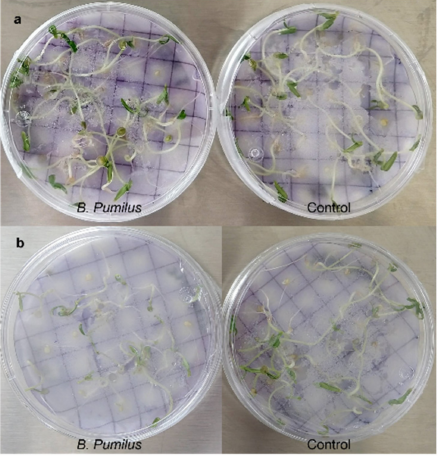
Figure 4. Effect of Bacillus pumilus on the germination of tomato and lettuce seeds. ( a ) Tomato seeds germinated in the presence of B. pumilus and the uninoculated control. ( b ) Lettuce seeds germinated in the presence of B. pumilus and the uninoculated control.